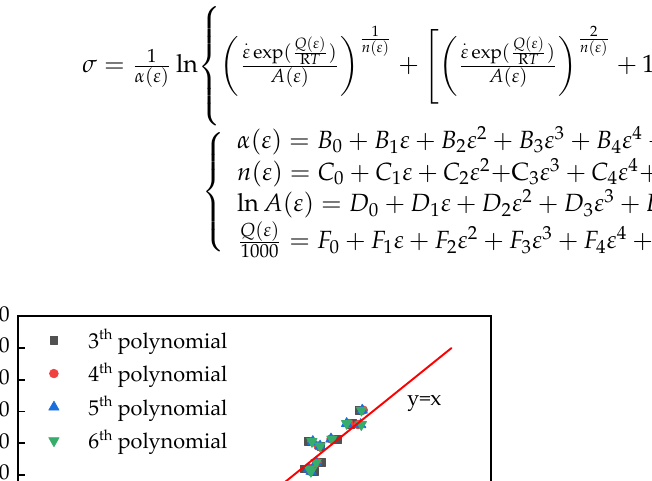
Table 3. Correlation coefficient and relative average error corresponding to different orders.